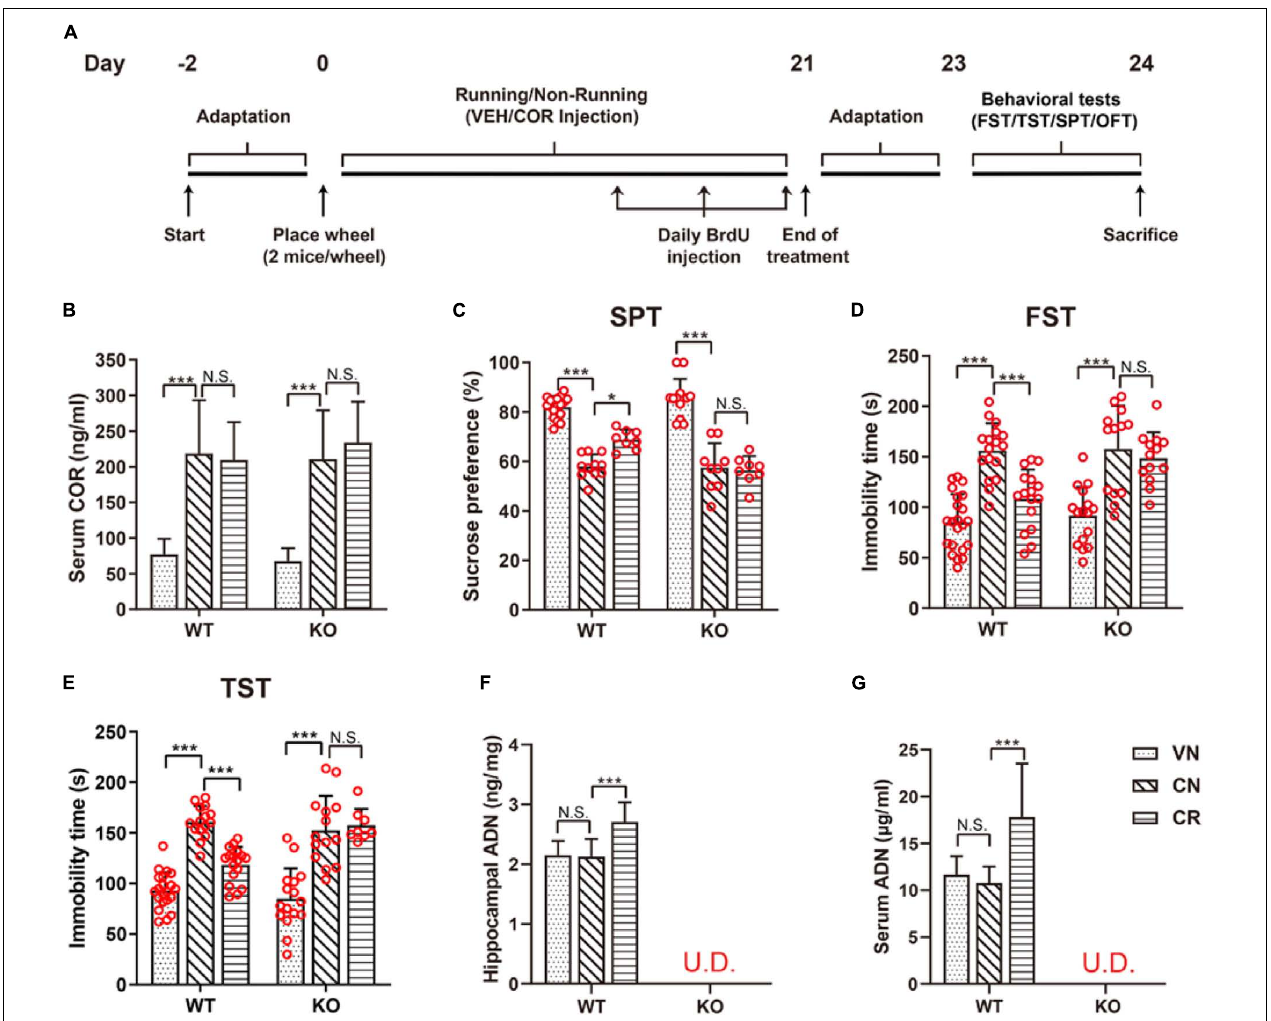
FIGURE 1 | Voluntary exercise is insufficient to reduce depression-like behaviors in ADN-KO mice under stress. (A) Experimental timeline for animal treatments. (B) Changes of the serum COR level following administration of COR with or without running. n = 10–11 mice/group. (C–E) Assessments of behavioral despairs after different treatments. There was no main difference of genotype in COR-induced depressive behaviors. However, voluntary exercise substantially raised sucrose preference in the SPT ( C ; n = 8–18 mice/group), decreased immobility time in the FST ( D ; n = 13–22 mice/group) and the TST ( E ; n = 8–21 mice/group) in COR-treated WT mice; these effects were diminished in ADN-deficient mice. (F,G) COR injections did not affect the hippocampal ( F ; n = 8 mice/group) or serum ADN level ( G ; n = 8 mice/group) in WT non-runners, while the 3-week voluntary running raised both. ADN was undetected in KO mice with the designated treatments. Data are shown as means ± SD. * p < 0.05, *** p < 0.001 by two-way ANOVA and Tukey’s post hoc test. N.S., non-significant; U.D., undetected; FST, forced swim test; TST, tail suspension test; SPT, sucrose preference test; OFT, open field test; COR, corticosterone; ADN,